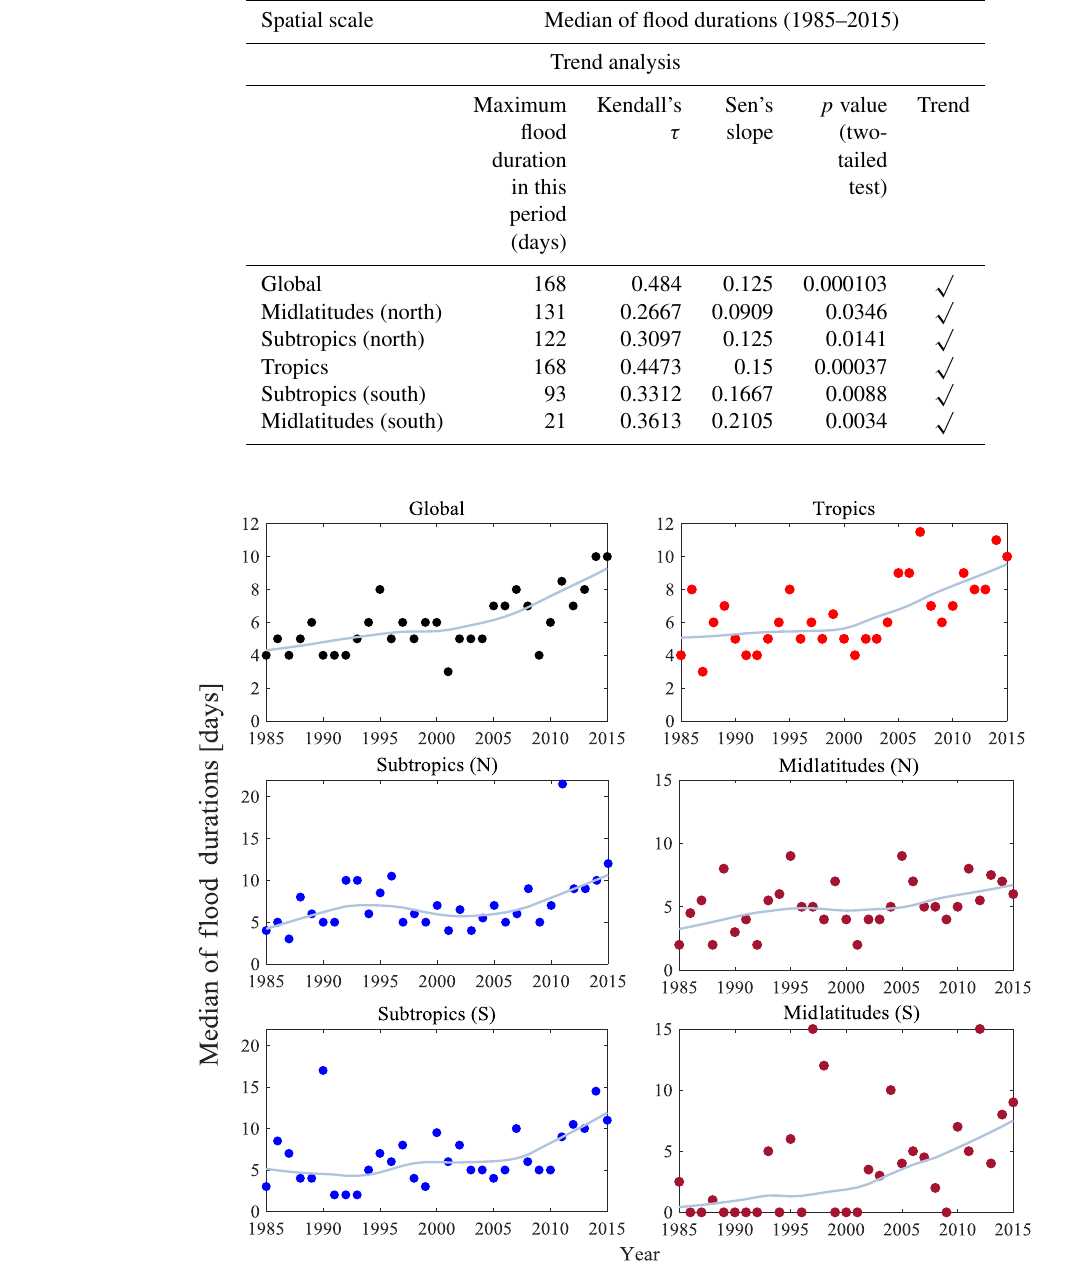
Figure 3. Same as Fig. 2 but for the median of flood